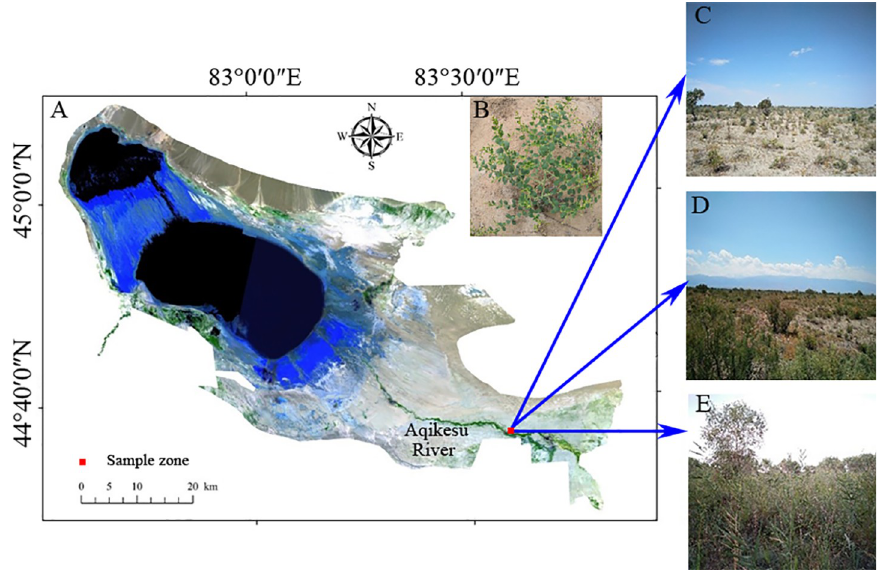
Fig 1. Schematic diagram of study area. (Autonomous Region is downloaded from The Gateway to Astronaut Photography of Earth website (https://eol.jsc.nasa.gov/SearchPhotos/). Because the map downloaded from this website is free and open to scholars, our study does not need to supply a copyright